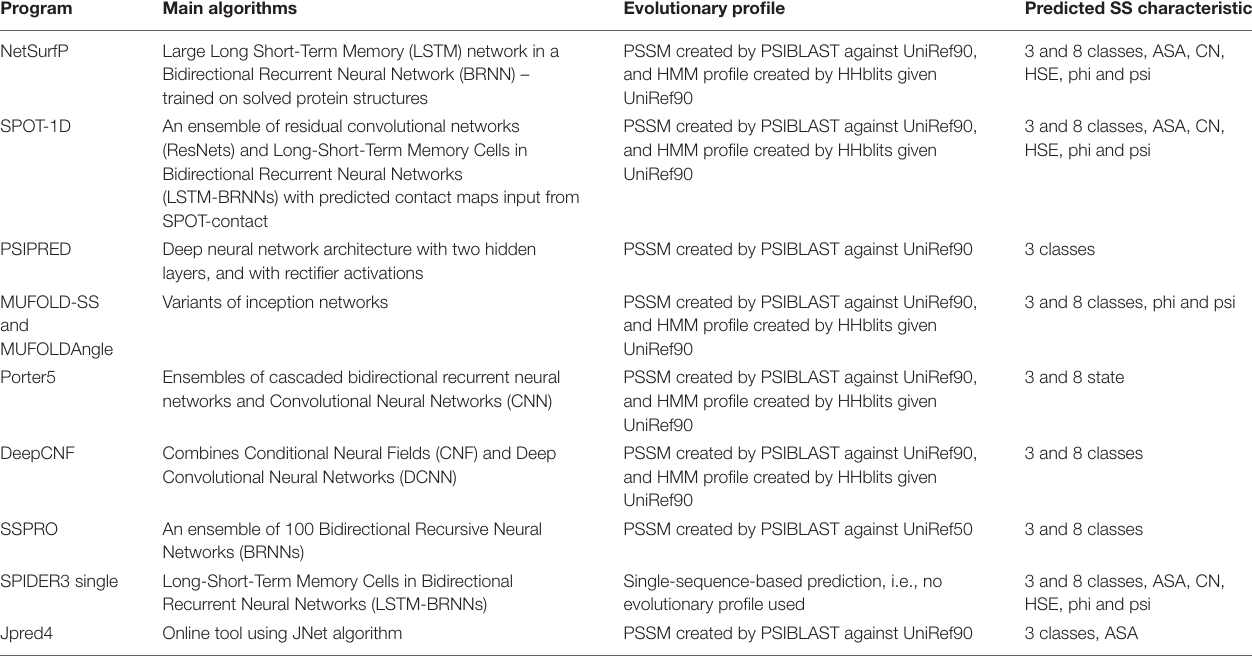
TABLE 6 | Publically available software for predicting protein secondary structure